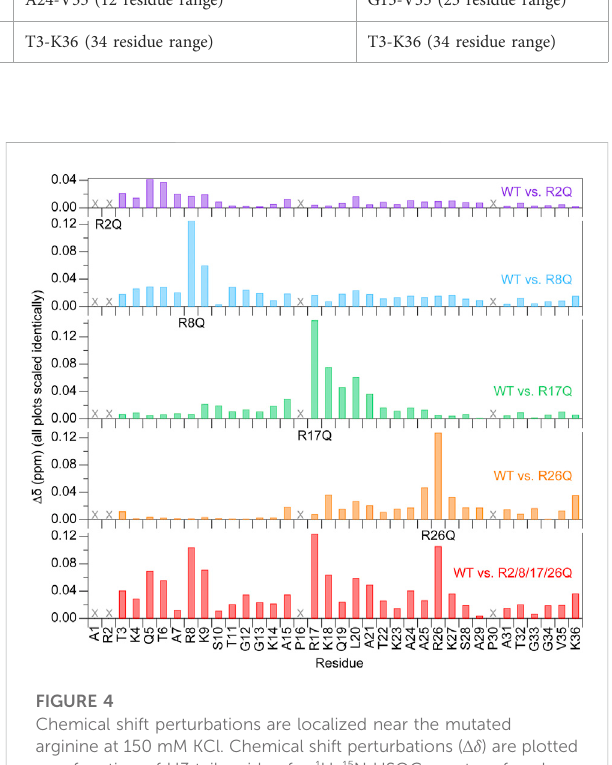
FIGURE 4 Chemical shift perturbations are localized near the mutated arginine at 150 mM KCl. Chemical shift perturbations ( Δ δ ) are plotted as a function of H3 tail residue for 1 H- 15 N HSQC spectra of each mutantas comparedtoWT-H3-NCPat150 mM KCl. “ X ” symbols markresiduesthatarenotvisible.Datawerecollectedat800 MHzand 304